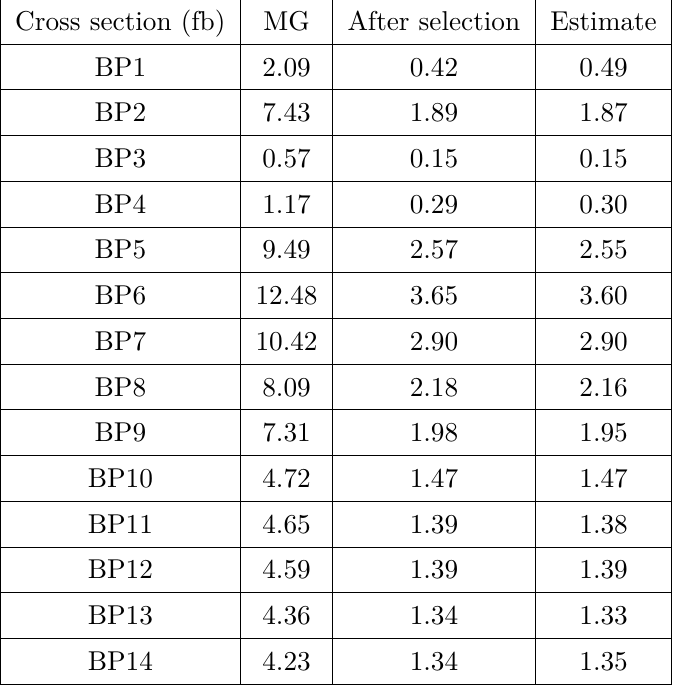
Table 5 . The cross sections of our signal processes with account cuts and detector effects (we also show the results from our analytical estimate).